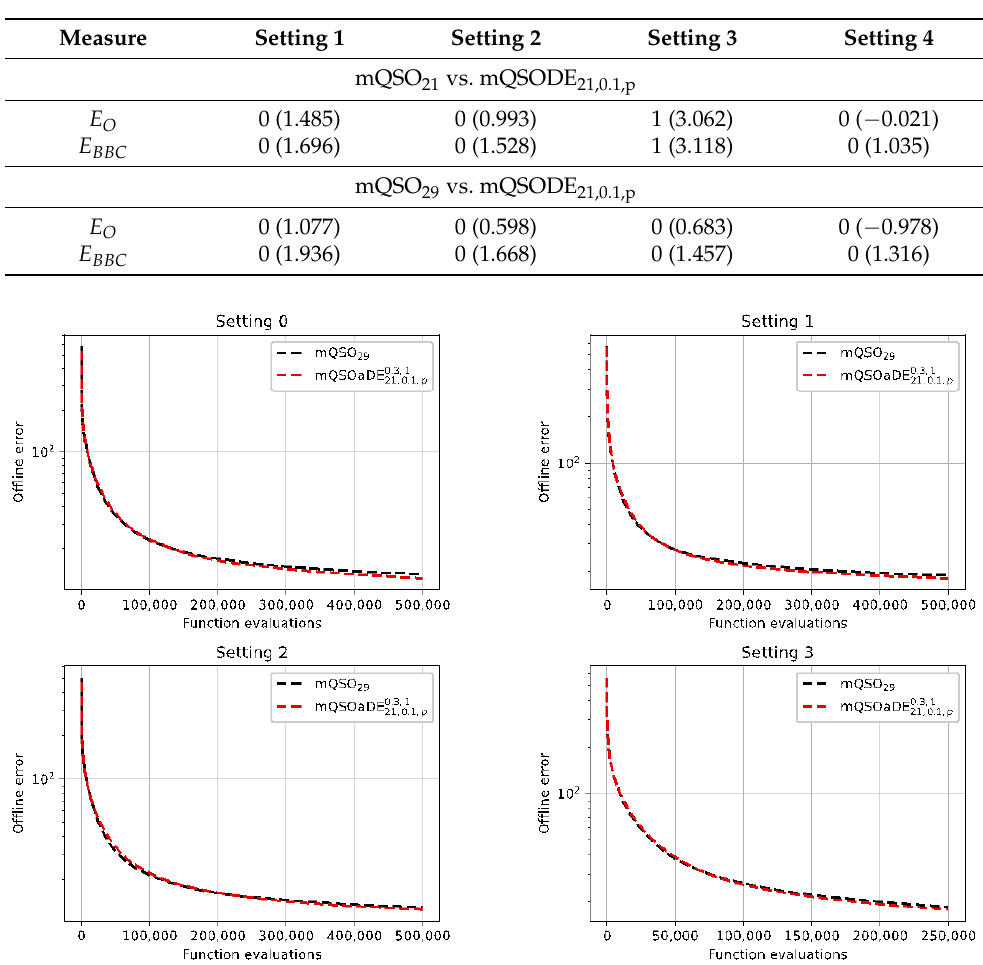
Table 9. Pairwise Mann-Whitney tests of mQSO and mQSODE, all settings, test results, and stan- dard scores.